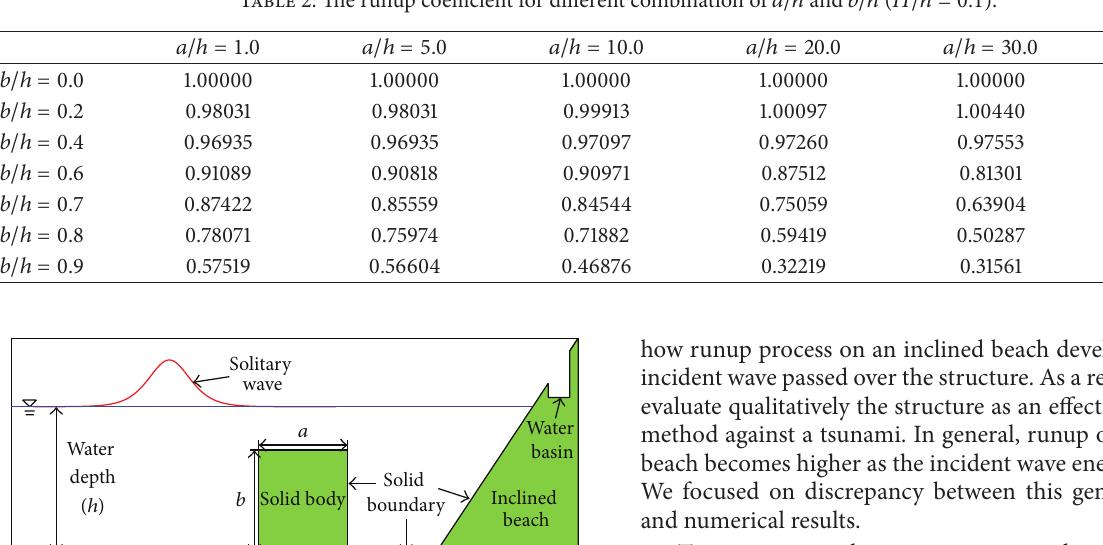
Table 2: The runup coefficient for different combination of 𝑎/ℎ and 𝑏/ℎ ( 𝐻/ℎ = 0.1 ).